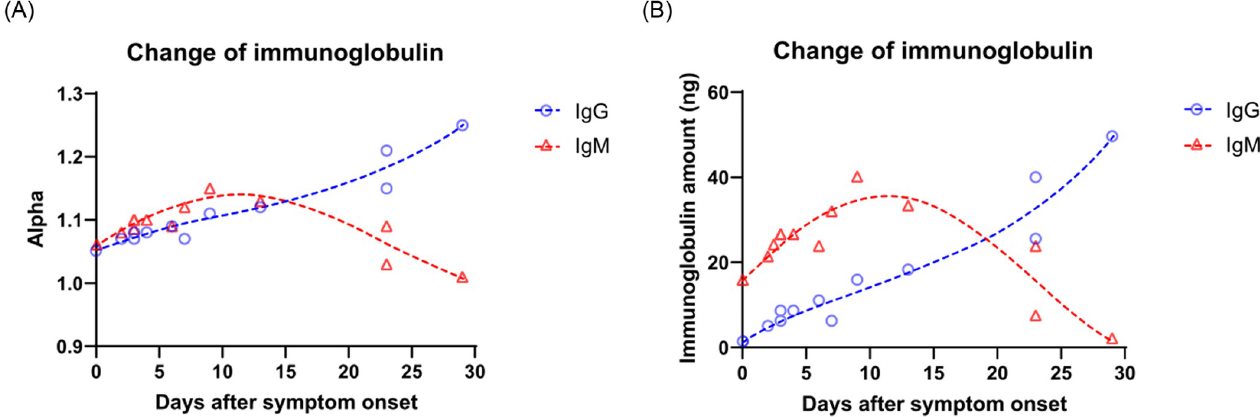
Fig 7. Increase of COVID-19 antibodies distribution by days after symptoms onset. After converting the α value into the actual antibody concentration unit (ng), a trend could be observed in the Covid-19 RT-PCR positive group that IgM reached the peak value first, and then IgG rose and maintained.